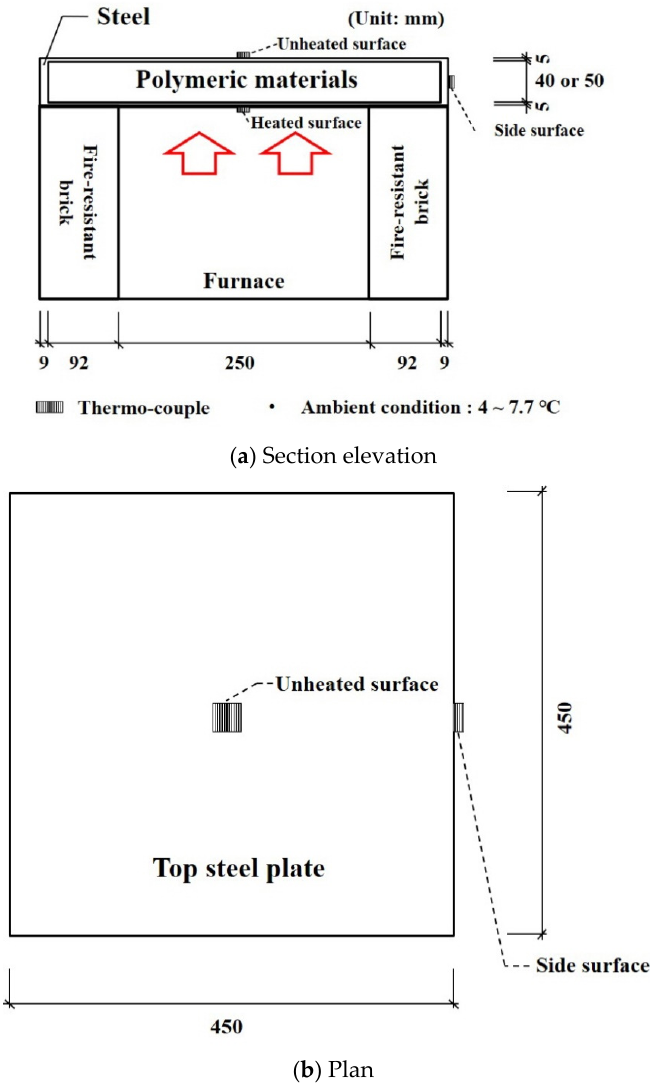
Figure 14. Setup of larger furnace tests: ( a ) Section elevation ( b ) Plan